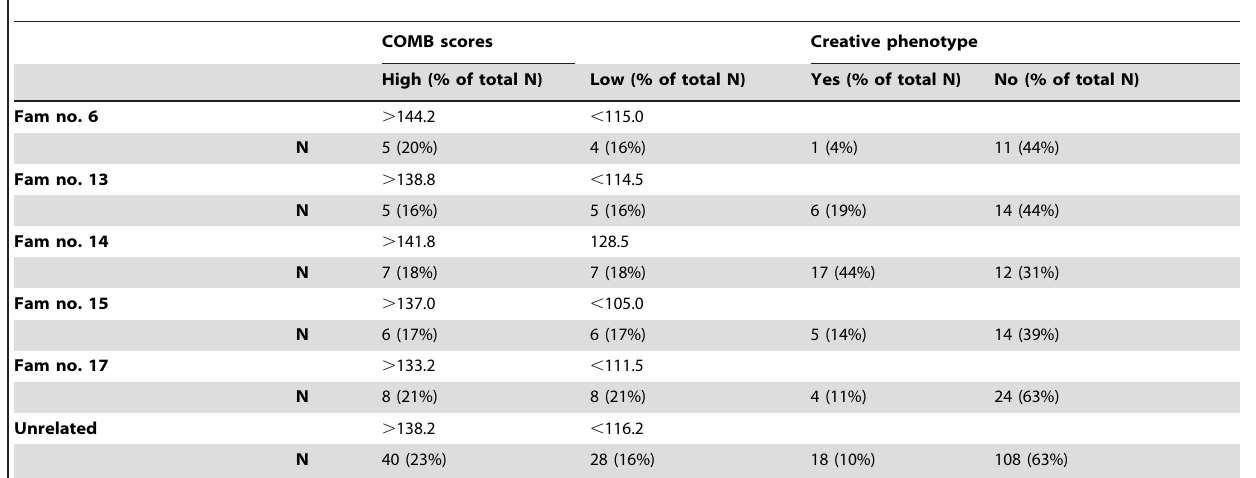
Table 2. Descriptive statistics for the analyzed music phenotypes in the study material.